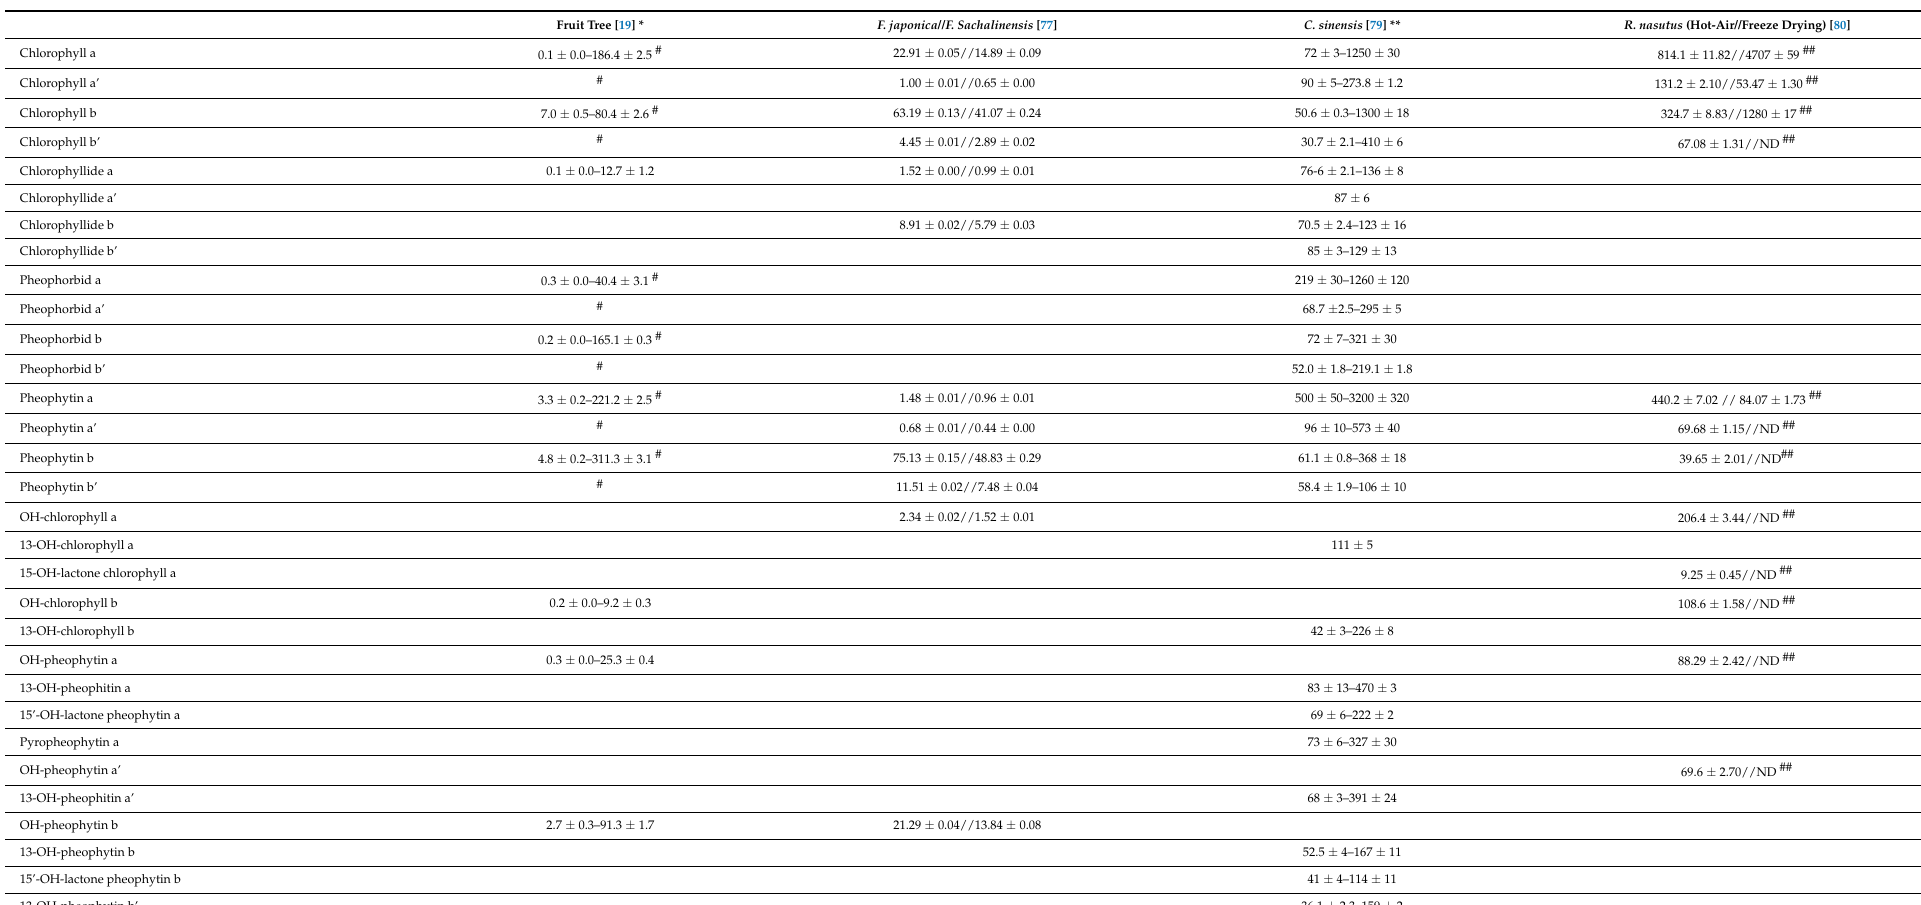
Table 9. Chlorophylls and their derivatives identified and quantified (mg/100 g dm) in edible plant